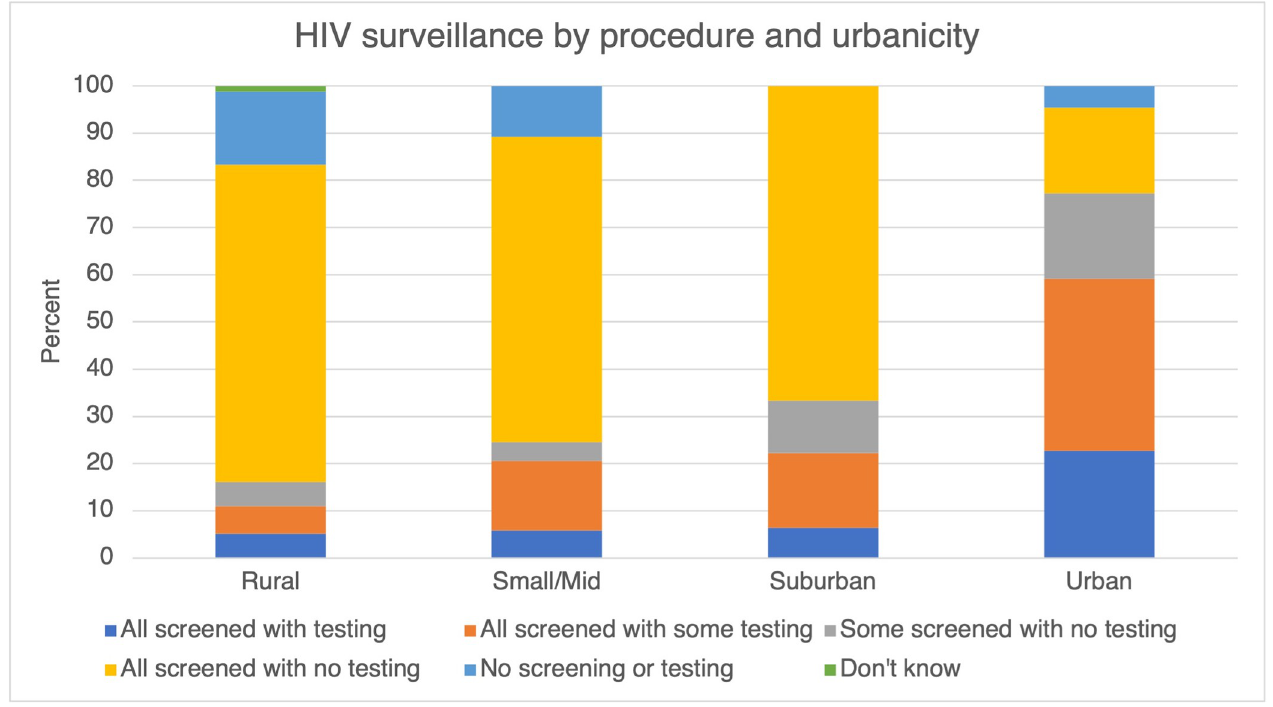
Fig 2. HIV surveillance by procedure and